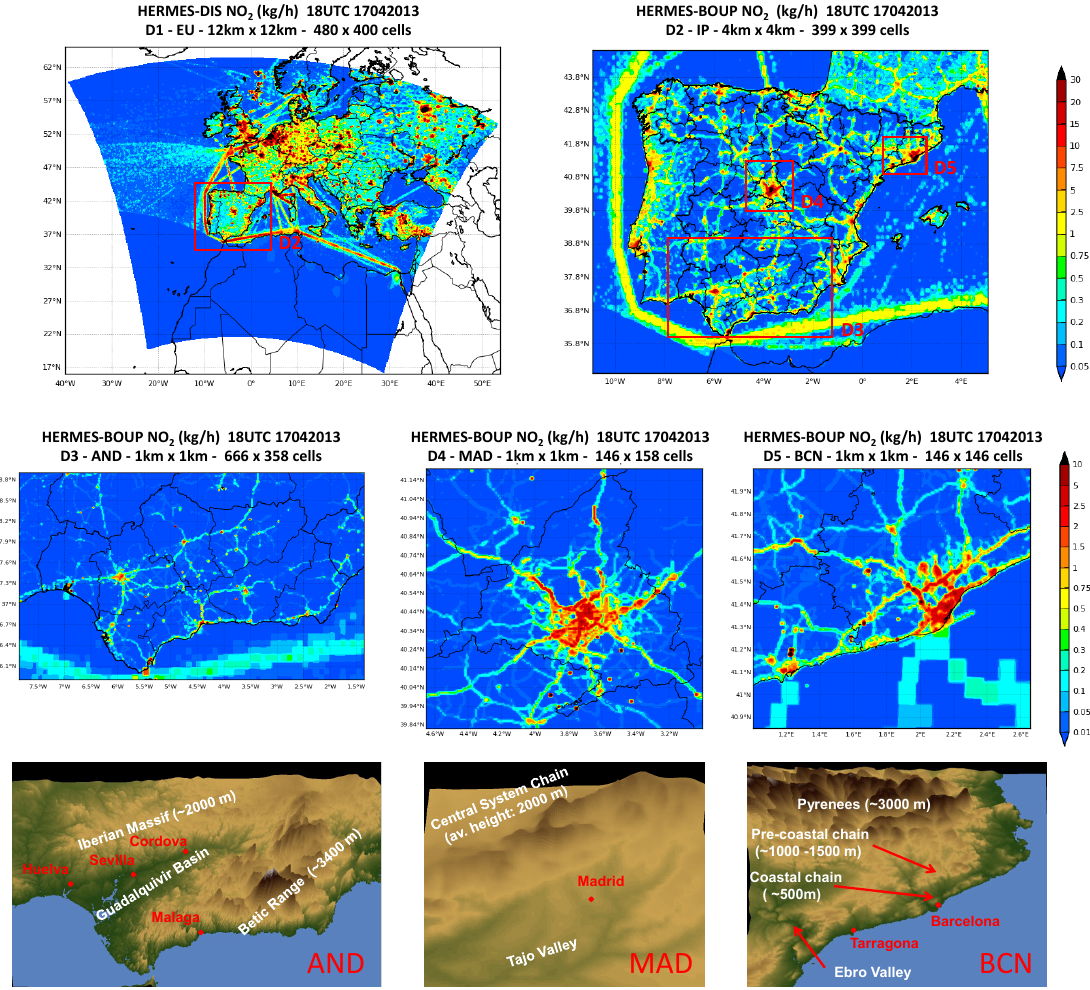
Figure 1. CALIOPE-AQFS nesting strategy (D domains) and study domains (Andalucia, AND; Madrid, MAD; and Barcelona, BCN). The color chart at the D domains shows the NO 2 emission rate (kgh − 1 ) for 17 April 2013 at 18:00UTC. The HERMESv2.0 model generates emissions at 12km × 12km over Europe (the mother domain, D1) by performing disaggregation from the EMEP database. The HER- MESv2.0 model estimates emissions at 1km × 1km, following a bottom-up